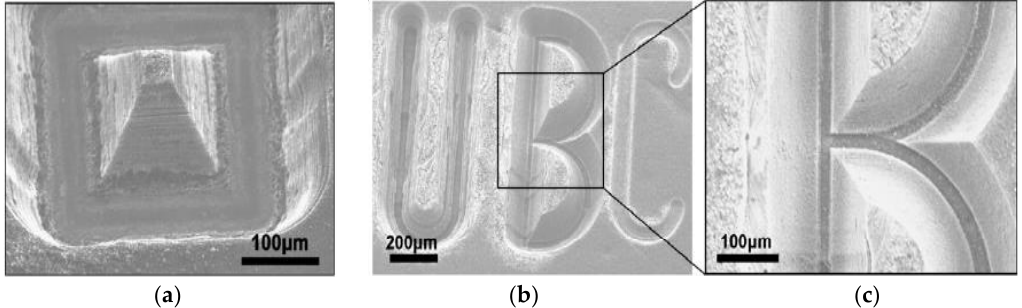
Figure 3. 3-D μEDM of CNT forests using electrodes with cone-shaped tips performed at 35 V and 10 pF to form ( a ) a pyramid structure and ( b ) letters. Note the difference in the depth of the three letters U, B and C. (Reproduced with permission from [52]).